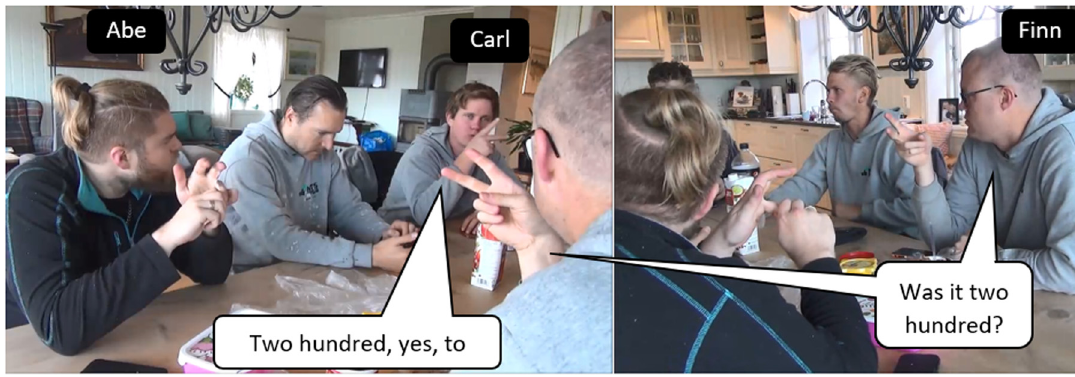
Figure 9: Finn holds “ TWO - HUNDRED? ” and Carl con fi rms. Abe is watching. ( Lines 2 and 3. )